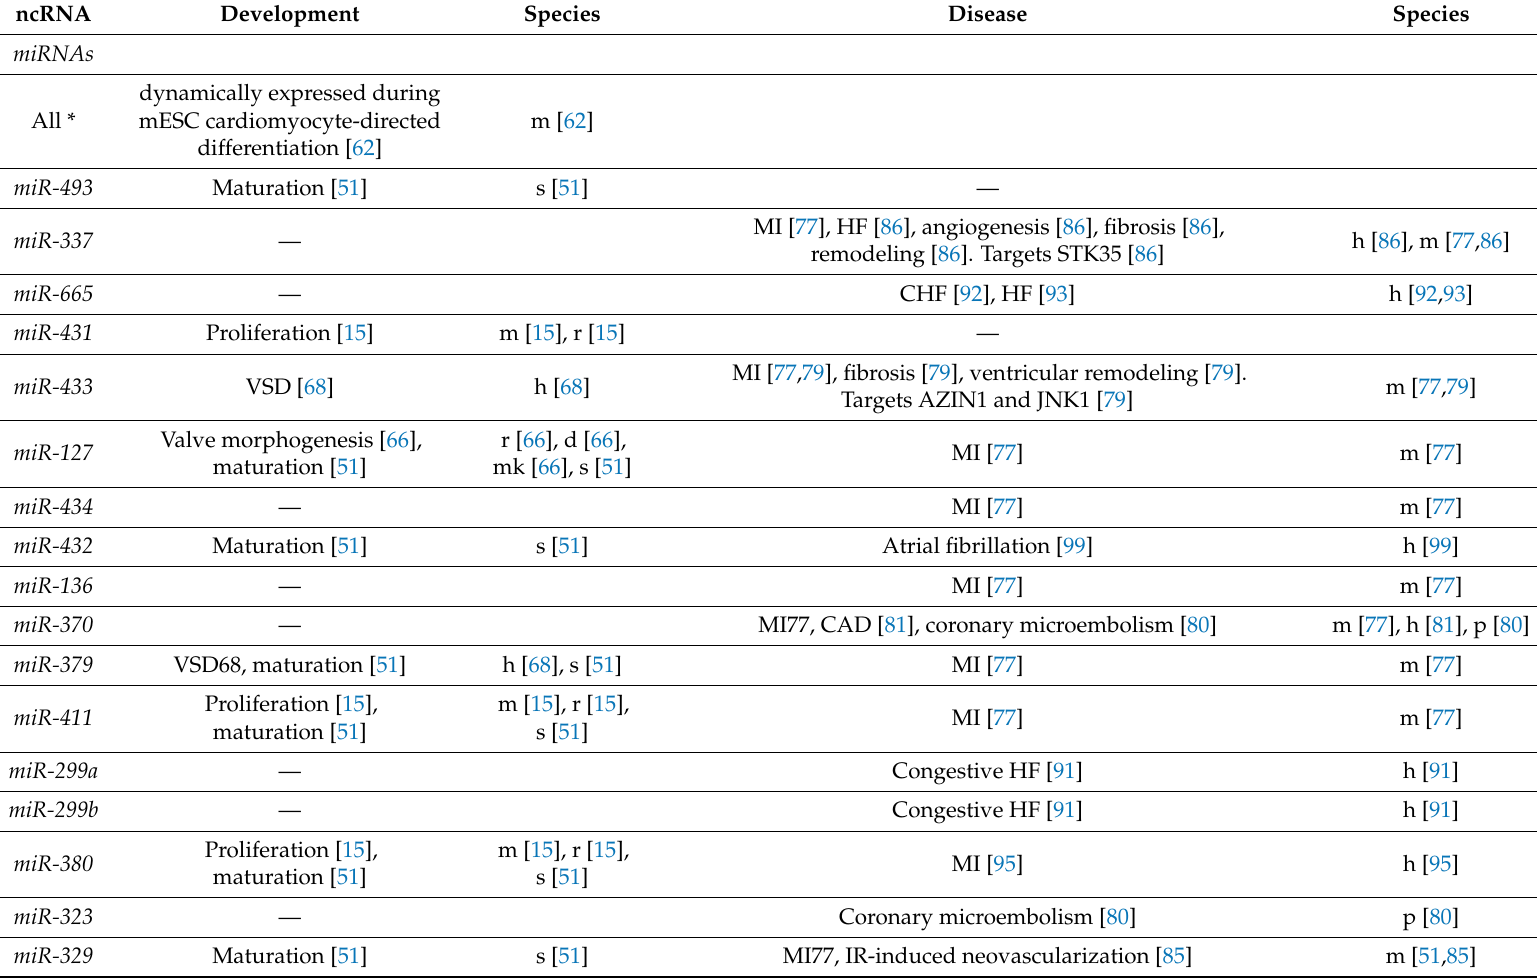
Table 1. Summary of Dlk1-Dio3 noncoding RNAs with known functions or differential expression in heart development and